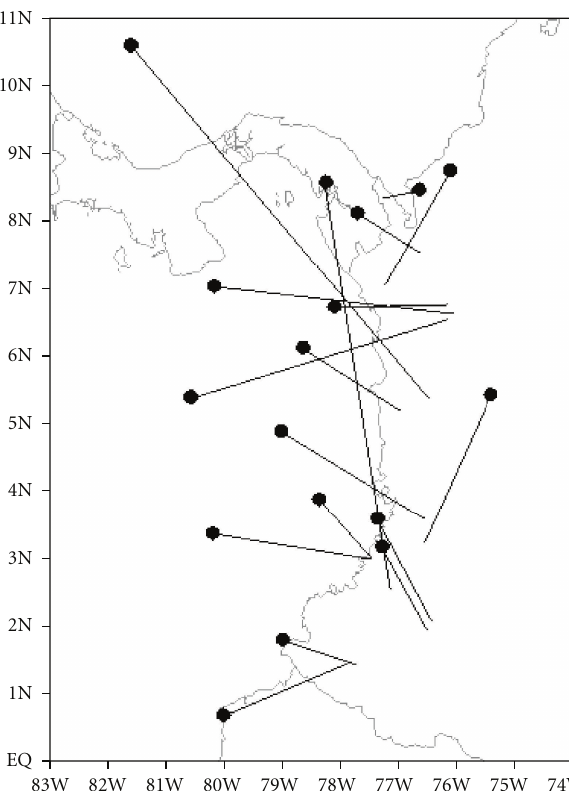
Figure 7: Relative frequencies of convective systems according to their average displacement as observed during 2003 and the annual mean, for: (a) continental systems; (b) oceanic